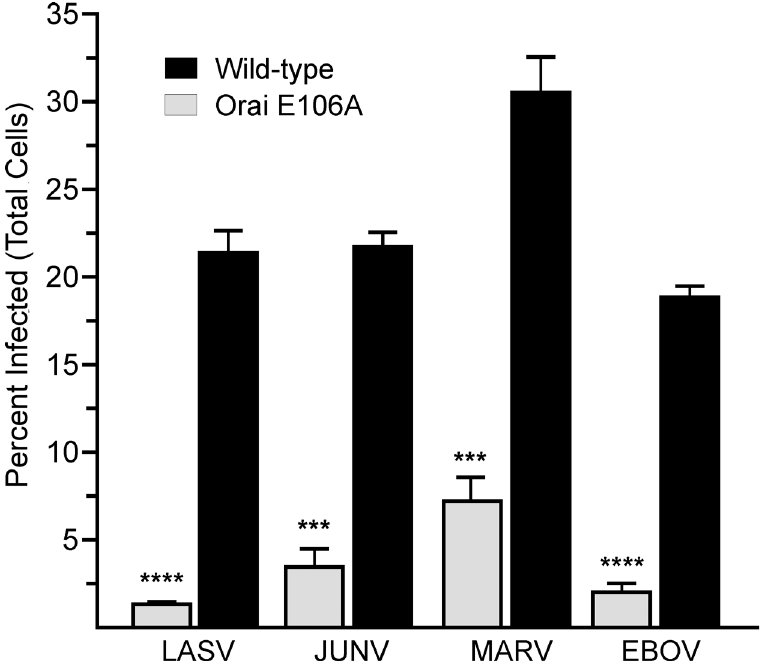
Fig 6. Genetic inactivation of Orai Ca 2+ permeation inhibits egress of authentic filoviruses and arenaviruses. Wild type HEK293T cells and a Ca 2+ permeation defective HEK293T line that stably overexpresses the dominant negative Orai E106A mutant were infected with LASV (MOI 0.05), JUNV (MOI 0.1), MARV (MOI 0.1), or EBOV (MOI 0.5). Cellular virus levels were detected by immunofluorescence staining of fixed cells at 72 (LASV) or 96 (JUNV, MARV, EBOV) hours post infection. The percent of infected cells relative to total viable cells per condition is plotted and error bars represent standard error of mean (SEM). Statistical significance was determined by student t test, two-tailed ( *** p < 0.0001, **** p < 0.0001 as